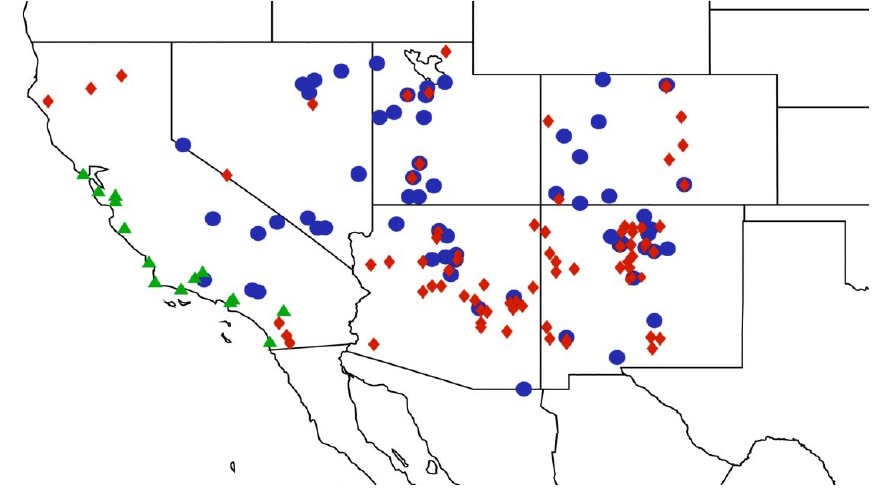
Figure 36. Distribution of Platypedia mohavensis mohavensis (blue circles), P. mohavensis rufescens (red diamonds) and P. barbata (green triangles).